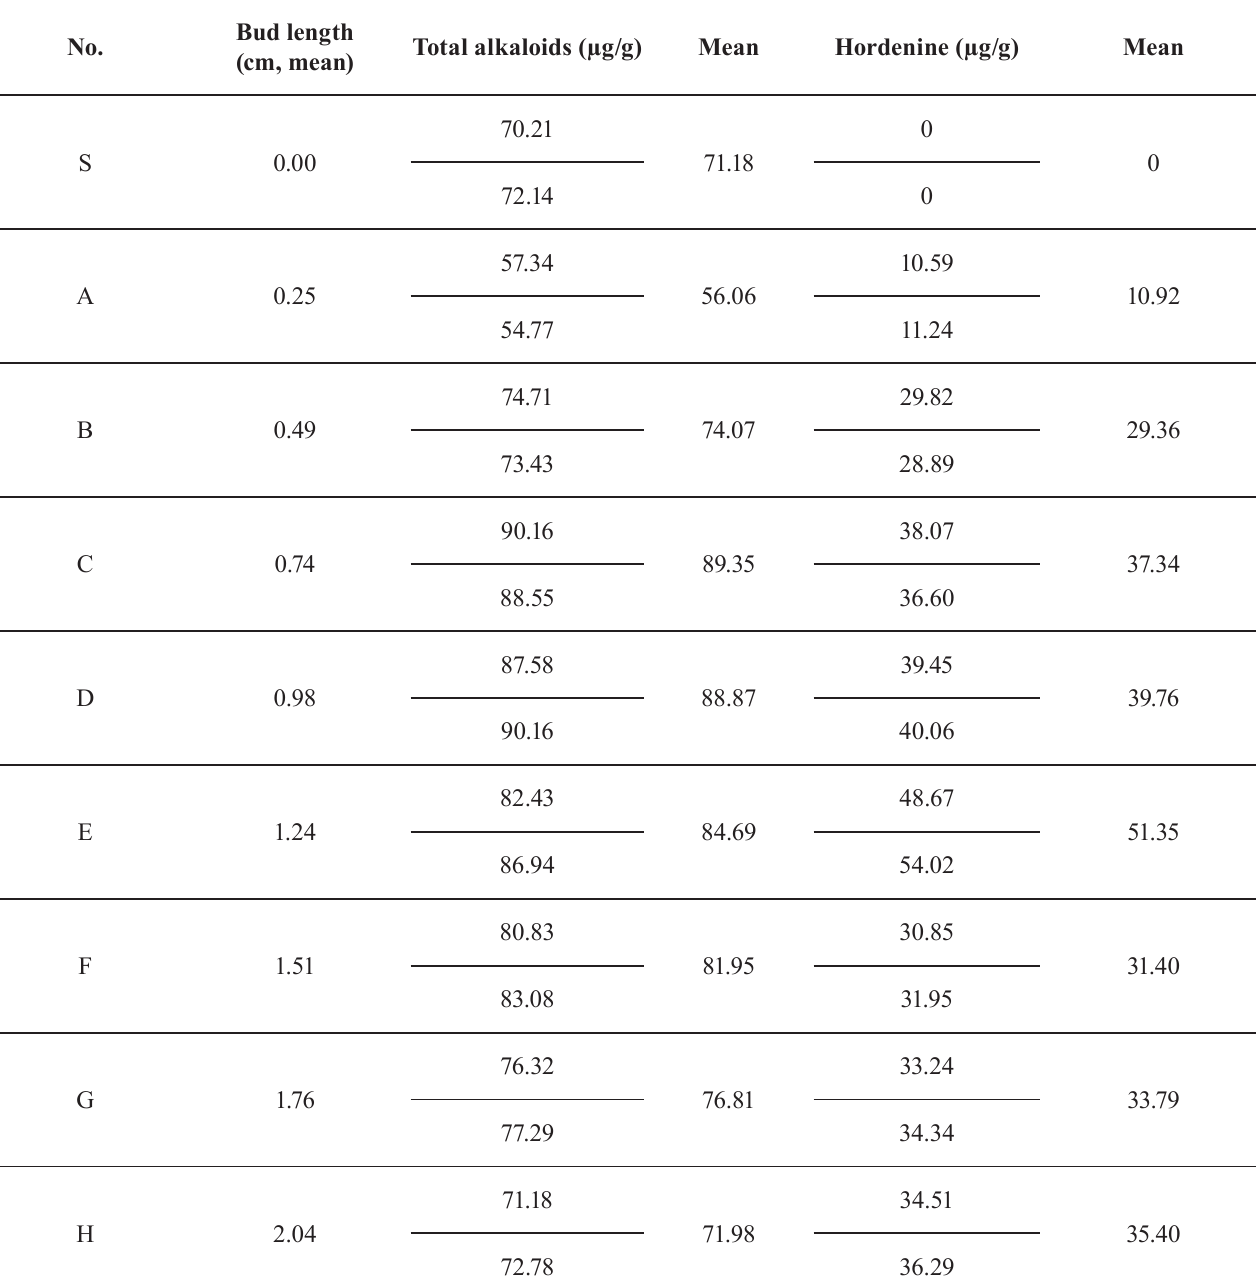
TABLE I – T he content of Total alkaloid and hordenine in different buds of malt